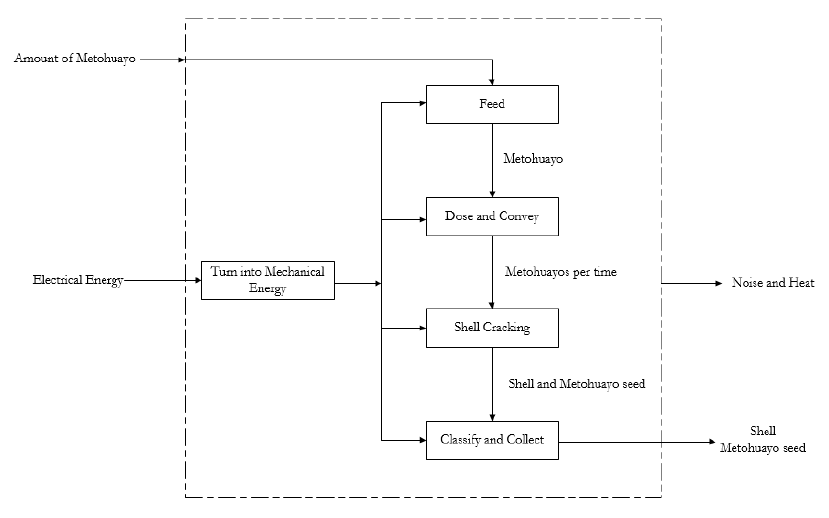
Figure 5. Optimal structure of functions.